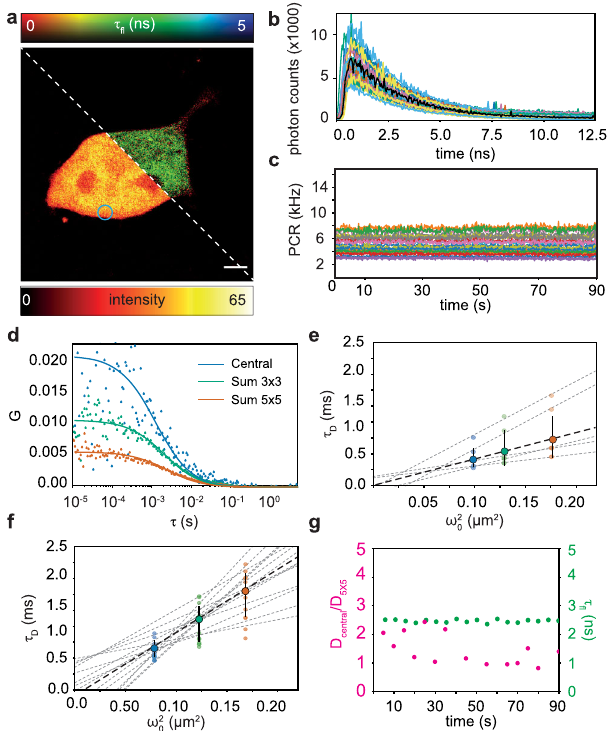
Fig.6|Fluorescence fl uctuationspectroscopyonlivingcells.a ISM(bottom-left corner) and FLISM (top-right corner) images of a HEK293T cell expressing eGPF. b , c Start – stoptimehistograms(centralpixelinblack)andintensitytimetracesfor all 25 channels of a 100 s FLFS measurement. The blue circle in a depicts the positioninthecellwherethemeasurementisperformed. d Autocorrelationcurves (scattered points) and fi ts (lines) for the central pixel, sum 3×3, and sum 5×5 curvesobtainedfrom( c ). e Spot-variationanalysis:thedashedblacklinerepresents the average ( D =34±12 μ m 2 /s, N =5) of the dashed light-gray lines. Each dashed light-gray line represents a different position within the same cell. f Spot-variation analysisasafunctionofthemeasurementtime-coarse.Datafrom( c ).Theintensity timetracesaredividedintochunksof5s,eachchunkisanalyzedbymeansofspot- variation FCS and generates a dashed light-gray line. The dashed black line repre- sentsthe average ( D =32±5 μ m 2 /s, N =14) of the dashedlight-graylines.Error bars in ( e , f ) represent standard deviations. g Ratio between the diffusion coef fi cients measured for the central pixel and sum 5×5 ( D central / D 5×5 ), overlapped with the fl uorescence lifetime as a function of the measurement time-coarse. Data from ( f ). Scale bar 5 μ m. Pixel dwell time 100 μ s. The data were acquired from fi ve different cells,ineachcellmultiplepositions(from3to5)weresampled.Setup:custom-built single-photonlaser-scanningmicroscopeequippedwitha5×5SPADarraydetector